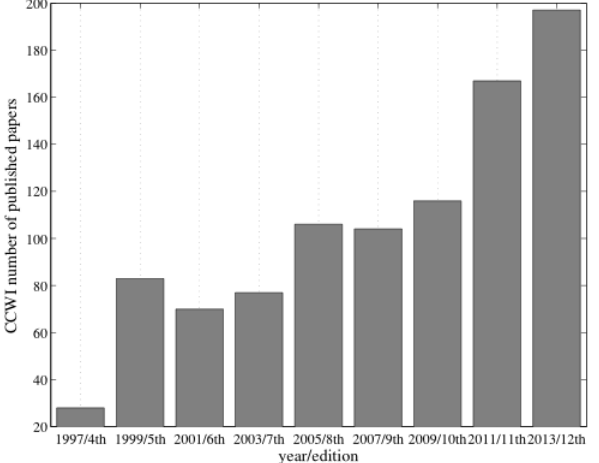
Figure 1. Last nine editions of CCWI conferences: number of pa- pers published in the proceedings (from Brunone and Giustolisi,